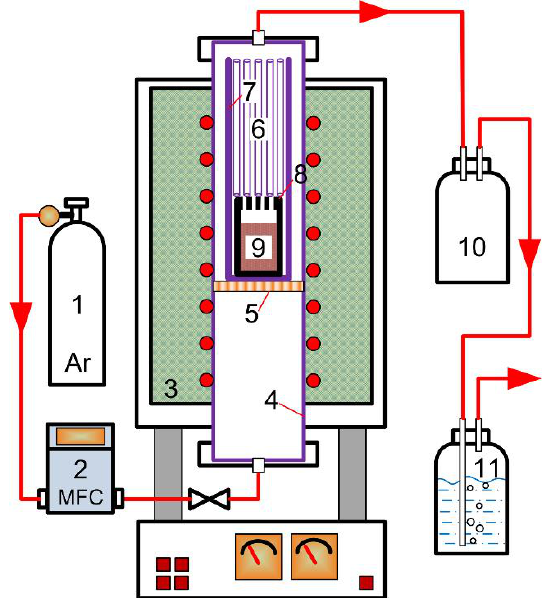
Figure 2. Schematic illustration of the experimental setup (1. Ar gas; 2. Mass flow controller; 3. Electric tube furnace; 4. Quartz tube; 5. Porous frit; 6. Thin quartz tubes for condensation; 7. Long quartz crucible; 8. Graphite crucible with lid (with five holes); 9. Sample mixture; 10. Bu ff er